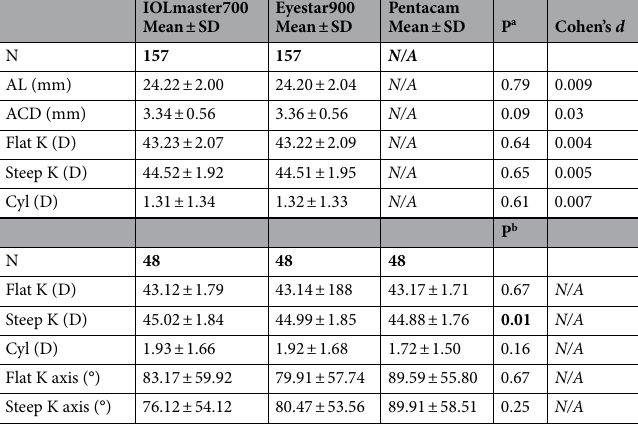
Table 2. Biometric parameters—mean differences (Group A). ACD anterior chamber depth, AL Axial length, Cyl : cylinder. a Paired sample t-test. b Friedman test. Significant values are in